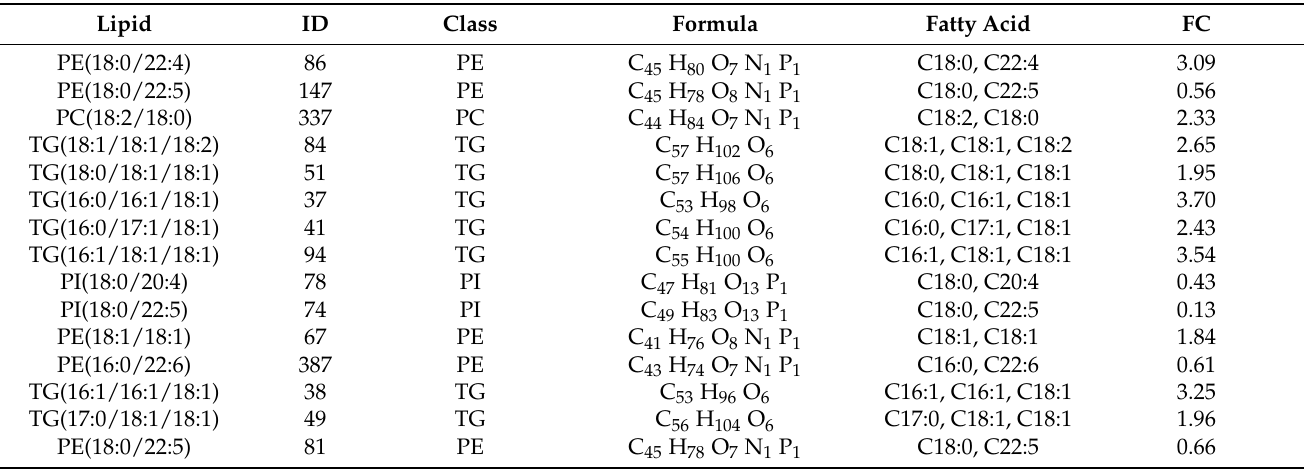
Table 2. The information on crucial lipids resulting in the lipid differences in yak LD between GF and SF groups.